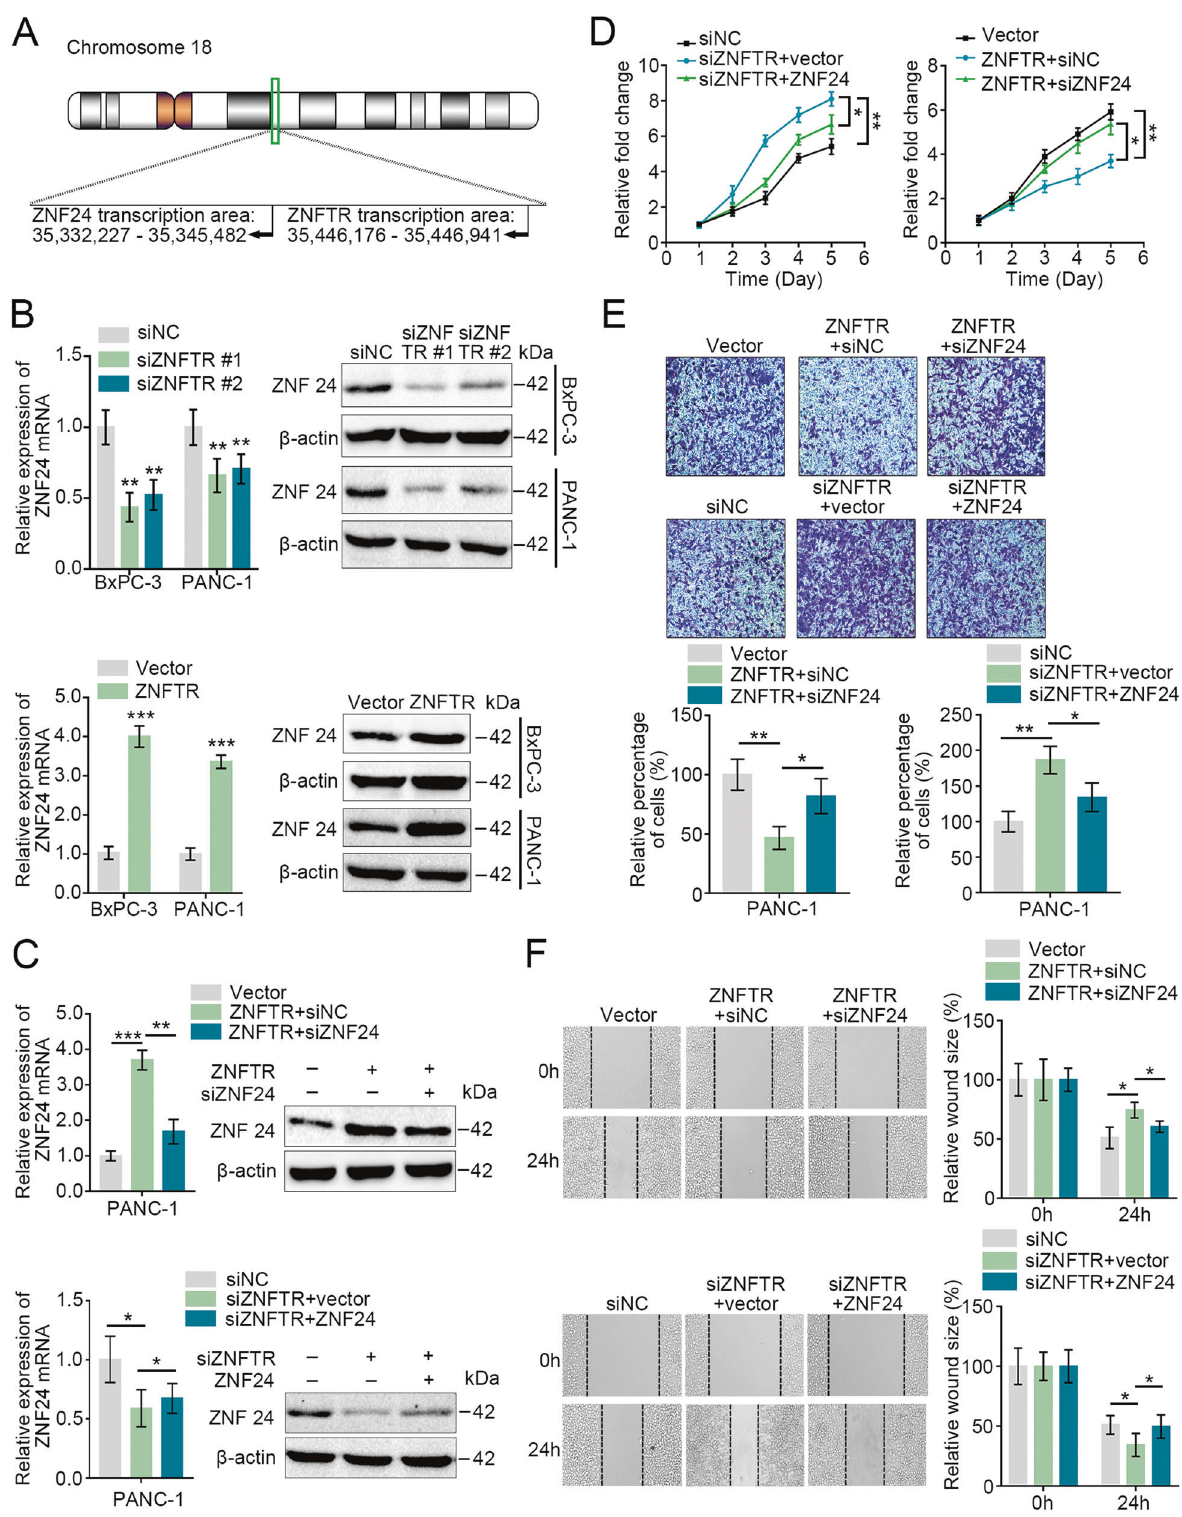
for ATF3 were found via the JASPAR database (Fig. 3F). The ChIP assay indicated an obvious enrichment of the promoter of ZNF24 by anti-ATF3 antibody (Fig. 3G). Furthermore, the transcriptional activity was signi fi cantly reduced in WT or MUT-1 promoter by overexpression of ATF3, while it was slightly reduced in